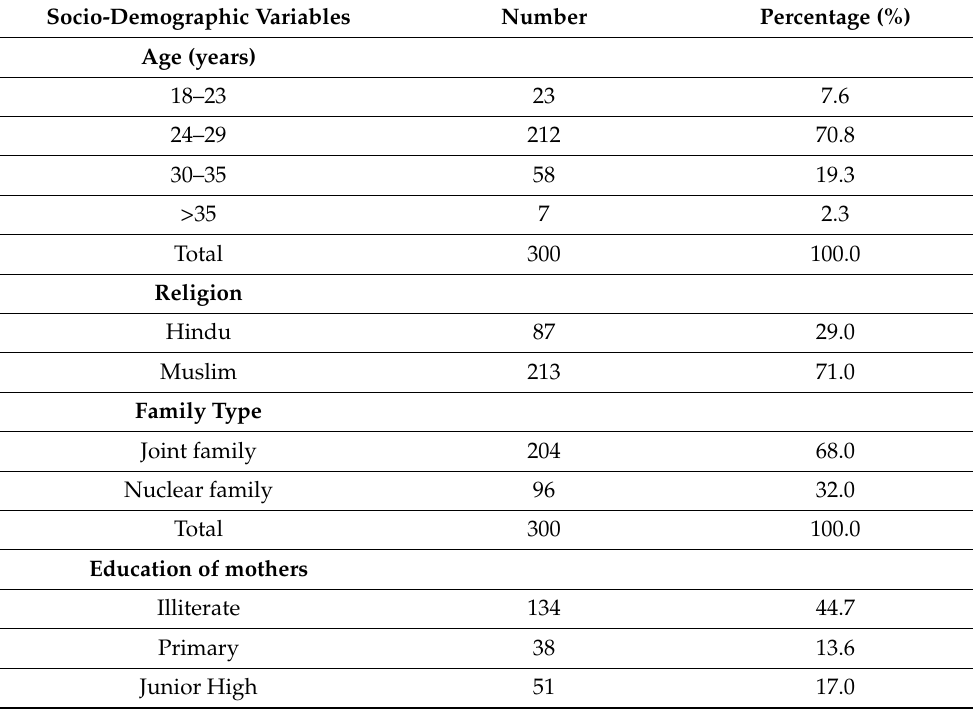
Table 1. Distribution of study participants based on demographic